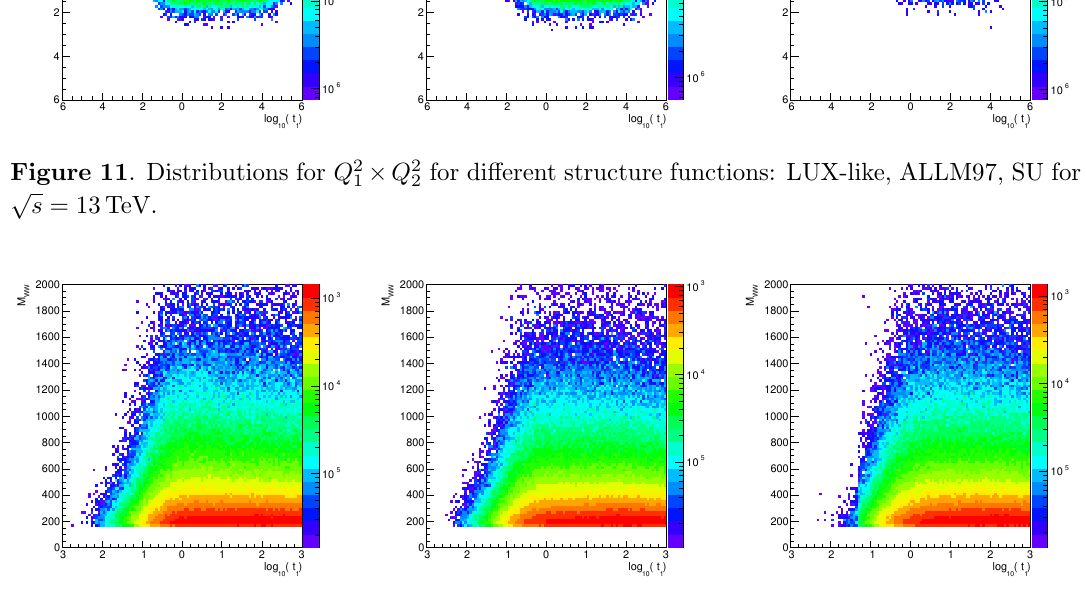
(cid:2) M WW (or Q 2 (cid:2) M WW ) for di(cid:11)erent structure functions: LUX-like, 1 2 p s = 13